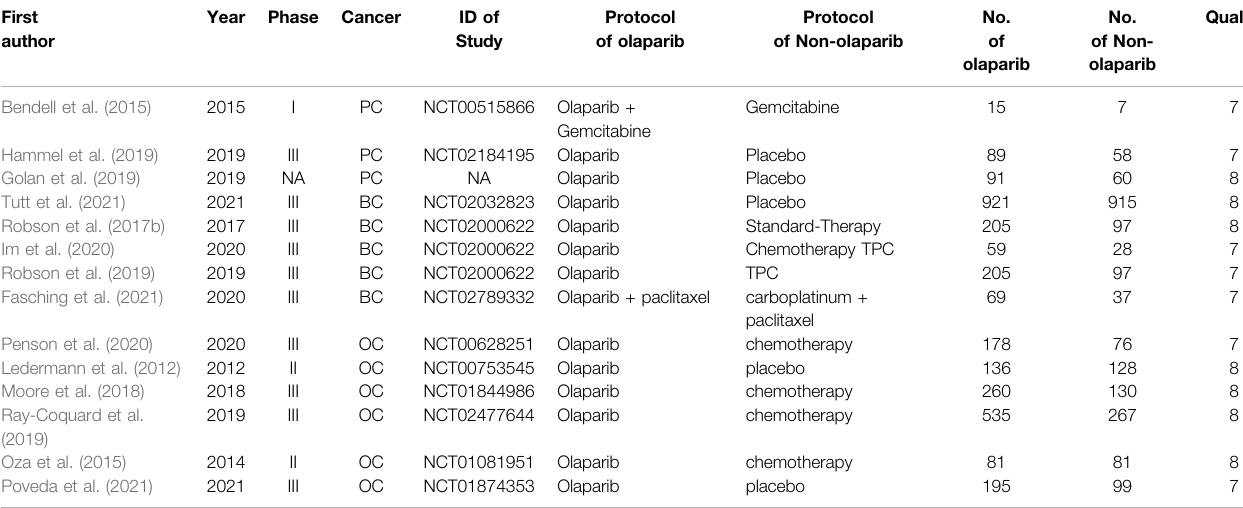
TABLE 1 | Basic characteristics of included studies (Ledermann et al., 2012; Bendell et al., 2015; Oza et al., 2015; Robson et al., 2017b; Moore et al., 2018; Golan et al., 2019; Hammel et al., 2019; Ray-Coquard et al., 2019; Robson et al., 2019; Im et al., 2020; Penson et al., 2020; Fasching et al., 2021; Poveda et al., 2021; Tutt et al., 2021).